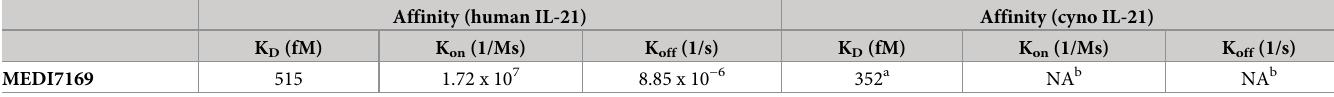
Table 2. Affinity of MEDI7169 to human and